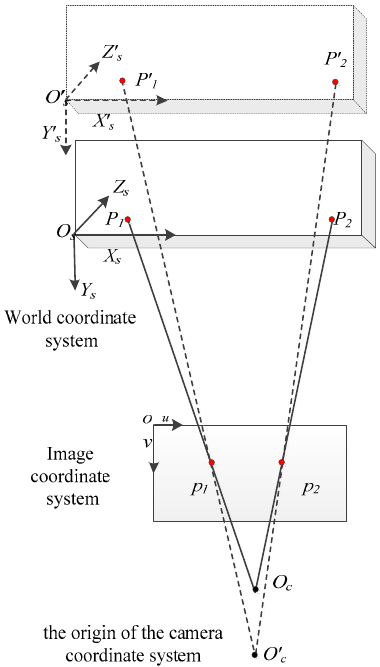
Figure 3. Relationship between the focal distance and translation.